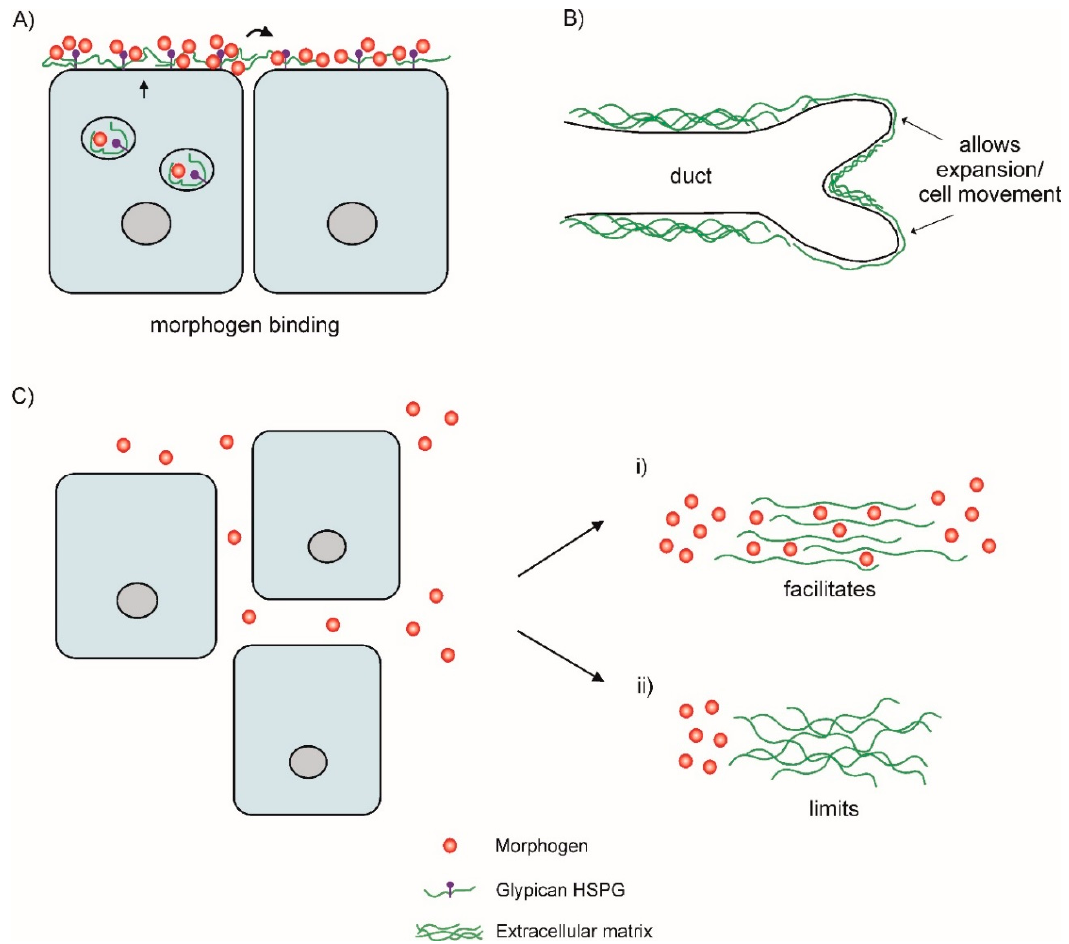
Figure 1. Mechanisms by which the extracellular matrix (ECM) affects cell movements and both morphogen binding and diffusion. MMPs are important enzymes in remodeling the ECM for these various purposes. ( A ) Morphogens can bind to the extracellular matrix via proteins, such as glypican heparan sulfate proteoglycans (HSPGs) and cell receptors. ( B ) Areas of thick ECM restrict cell movement, whereas a thin ECM allows for tissue expansion necessary in processes like branching morphogenesis. ( C ) The ECM can modify morphogen diffusion rates by either facilitating or limiting morphogen diffusion through the ECM. Modified from References [17,19].